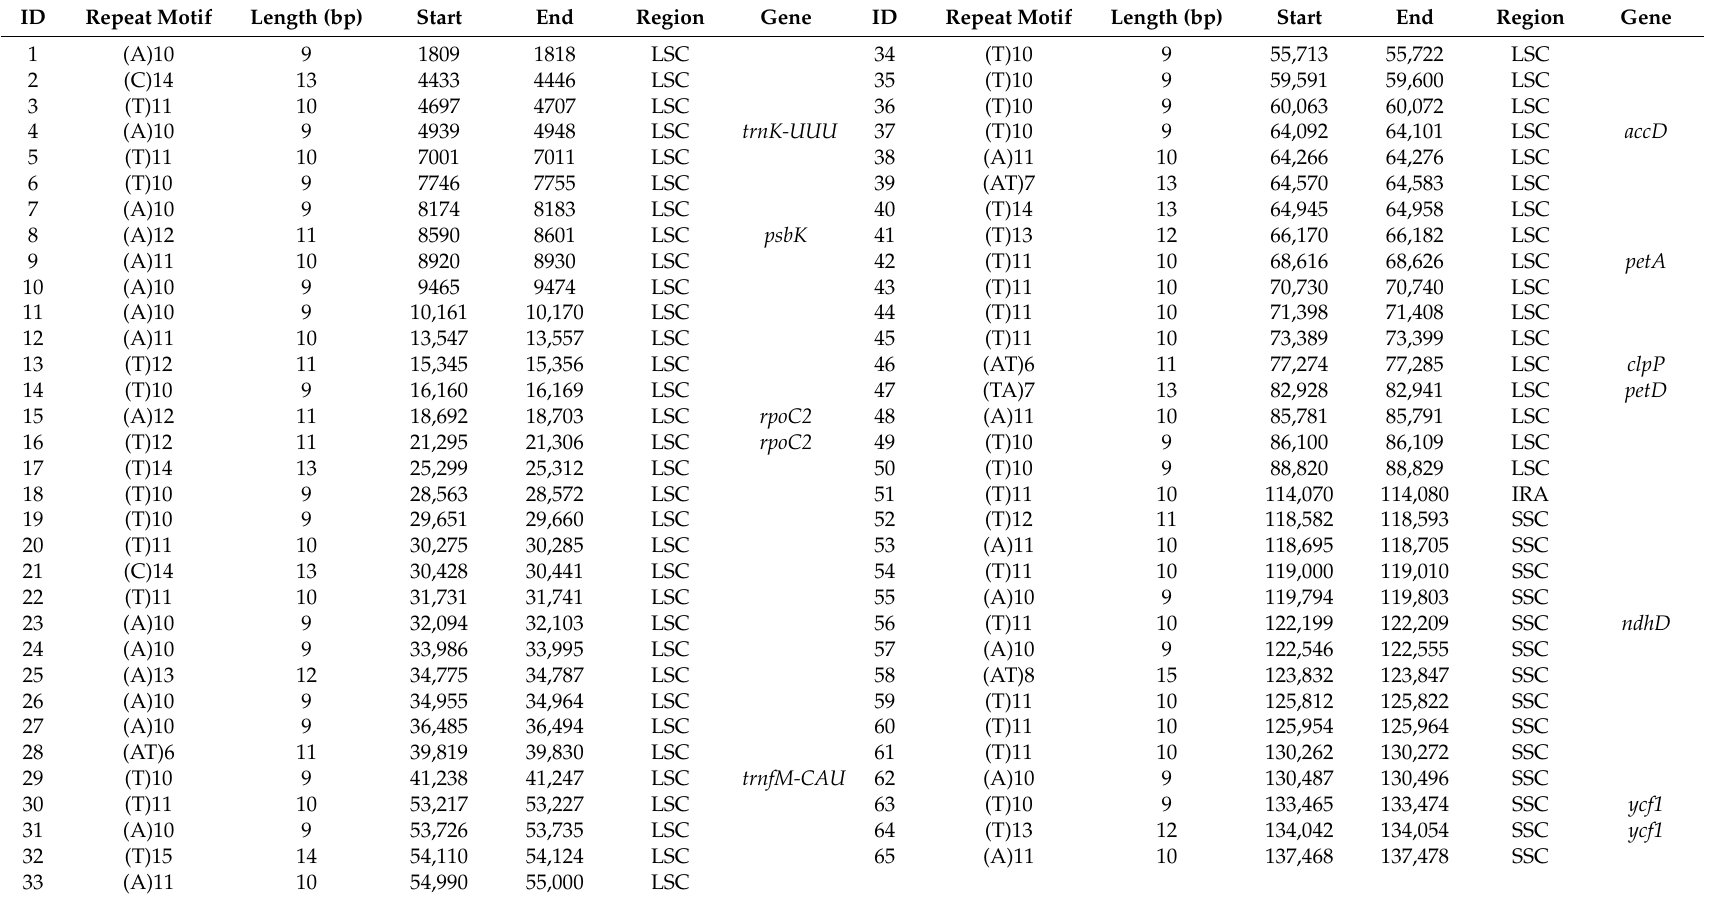
Table 6. Simple sequence repeats (SSRs) in the Q. acutissima chloroplast